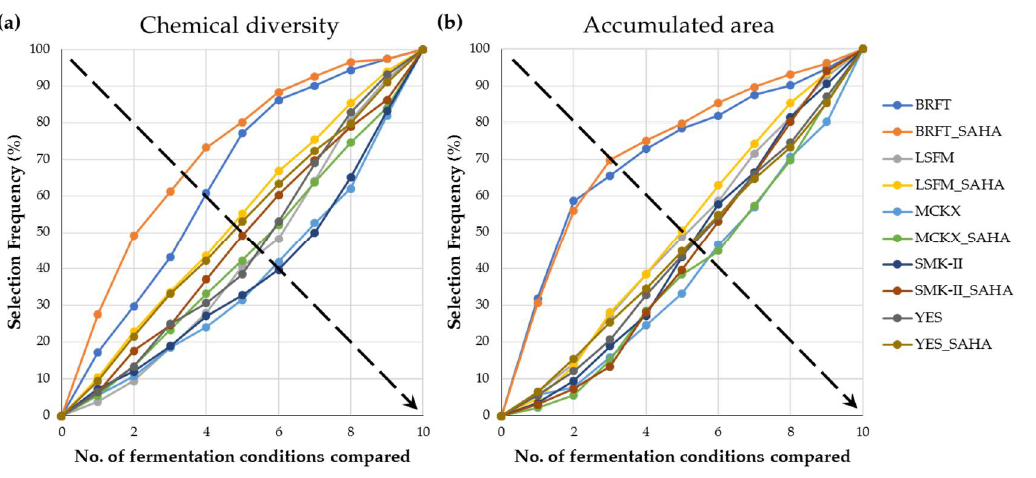
Figure 6. Ranking of all fermentation conditions studied in the total fungal population ( n = 232); ( a ) based on the exclusive chemical diversity generated (presence or absence of [rt- m / z ] components); ( b ) based on the amount of metabolites (as accumulated area of [rt- m / z ] components).